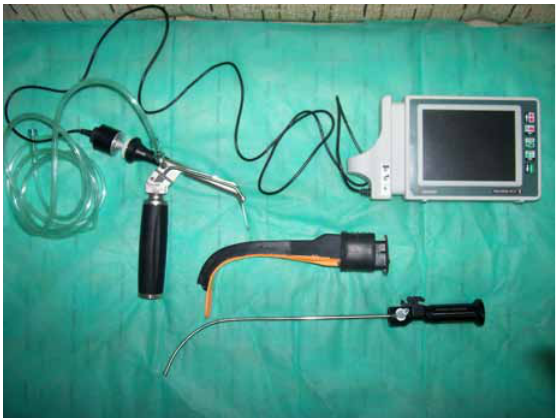
Figure 1. (From up) Truview PCD with oxygen catheter, nasotra- cheal intubation optical laryngoscope AirTraq, optical stylet Levitan